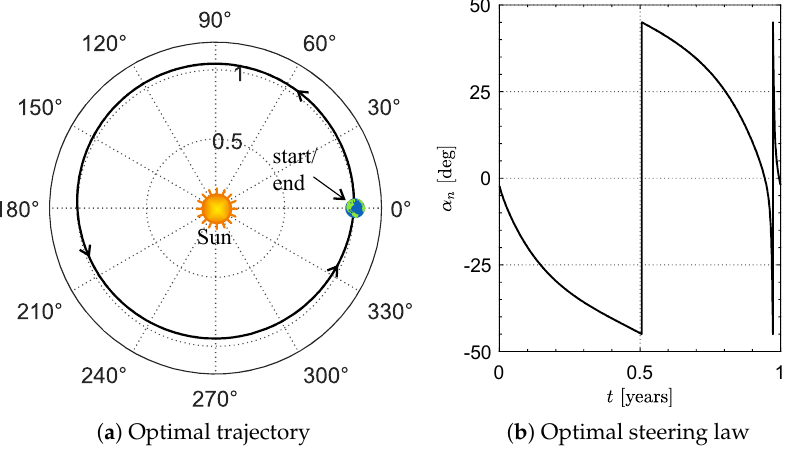
Figure 3. ∆ V -EGA maneuver trajectory and corresponding optimal steering law α n = α (cid:63) n ( t ) for = 1km/s, and t = a c = 0.1mm/s 2 , V ∞ f 0